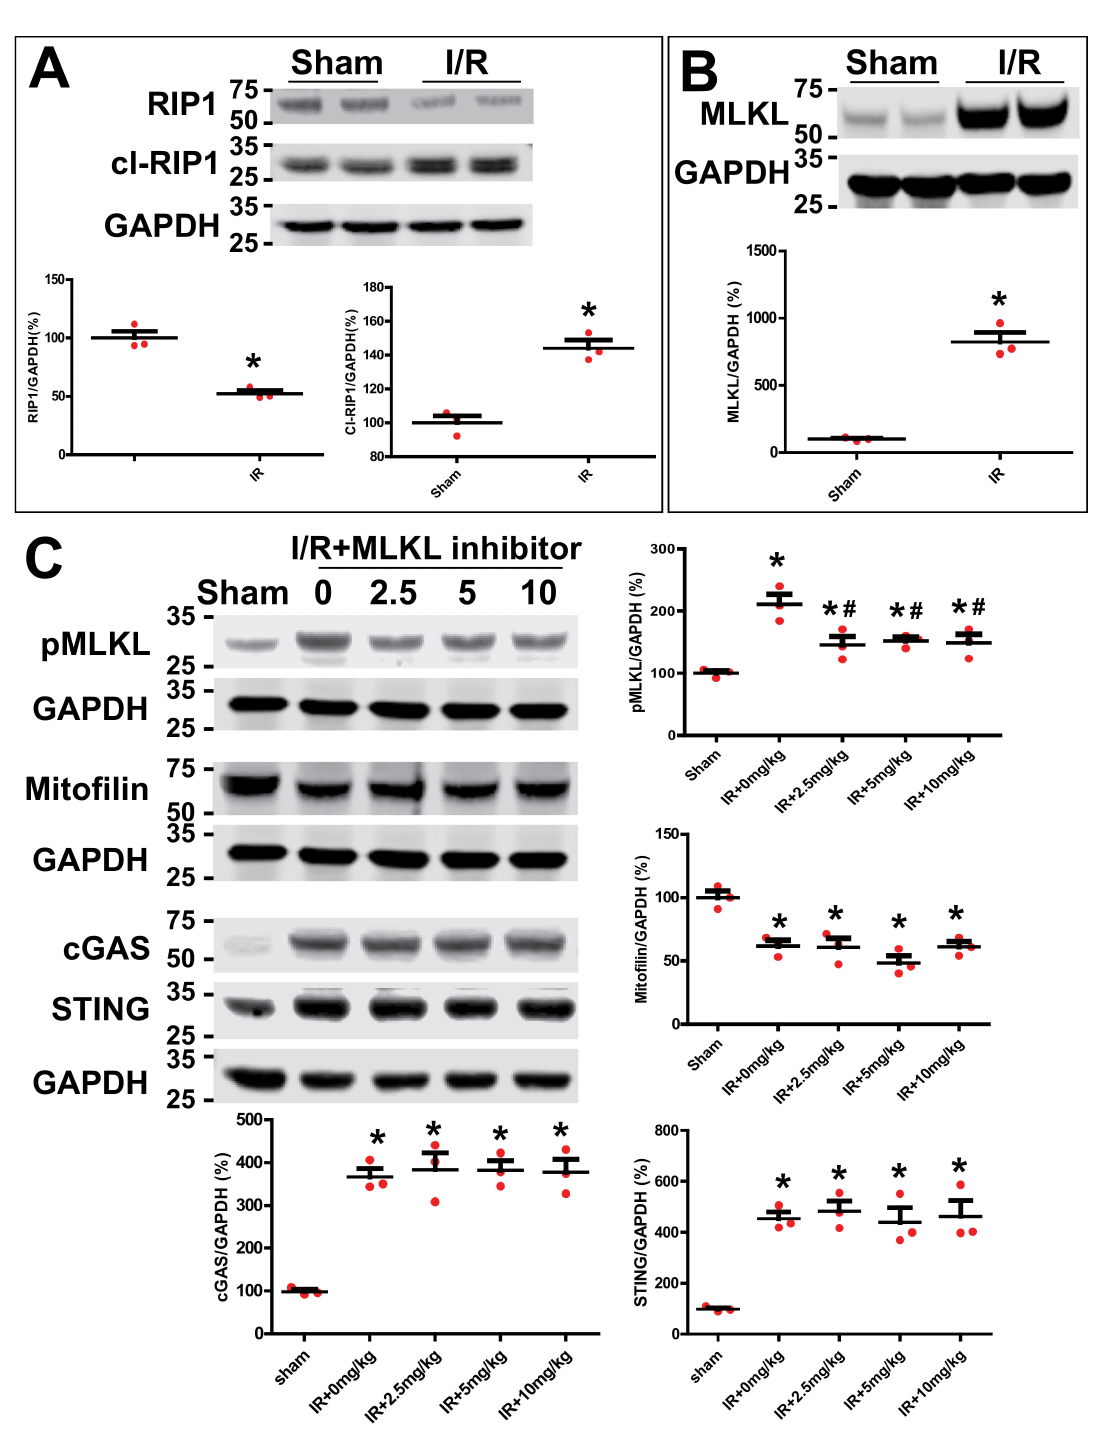
Figure 10. Inhibition of MLKL does not affect cGAS–STING pathway in renal I/R injury. ( A ) Immunoblot and graph showing increases in the levels of cl-RIP1 and reductions in RIP1 levels